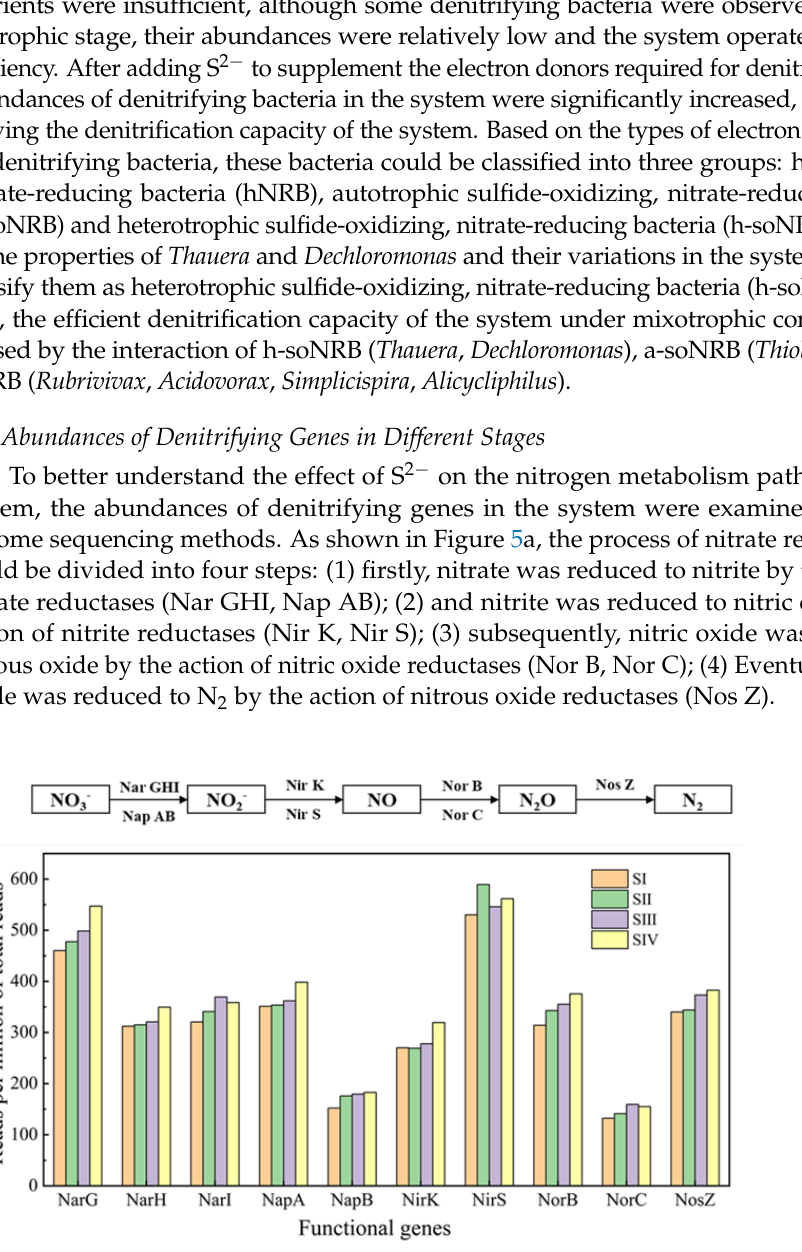
Figure 5. Nitrogen metabolic pathways ( a ) and the functional genes of nitrogen metabolism at different stages ( b ).